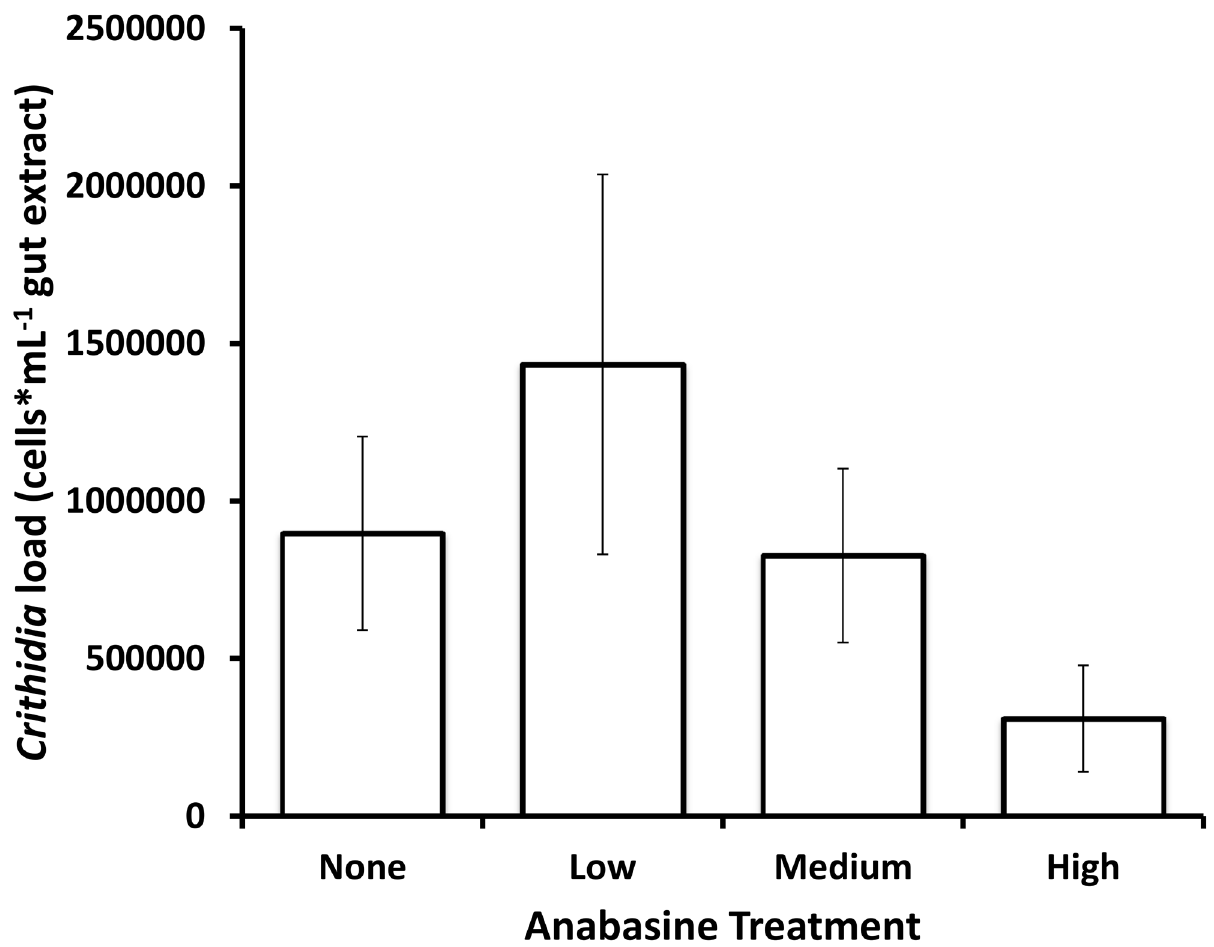
Fig 2. Effects of anabasine treatment on parasite load. Anabasine treatment had a significant effect on C . bombi parasite load at time of death (P = 0.015). Error bars show mean ± SEM of untransformed data.